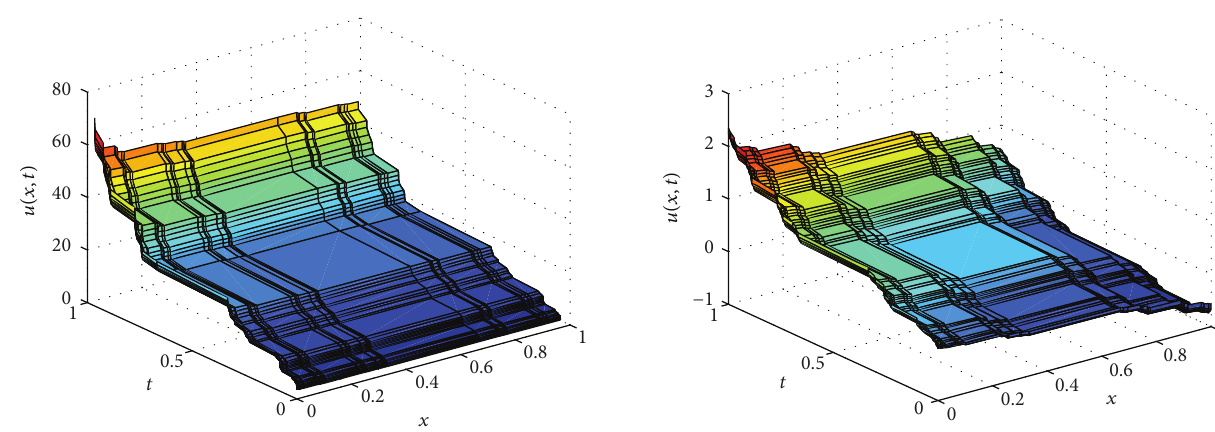
𝑢(𝑥,𝑡) with the parameter 𝛼 = ln 2/ ln 3